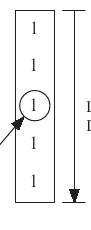
Figure 7. Structure